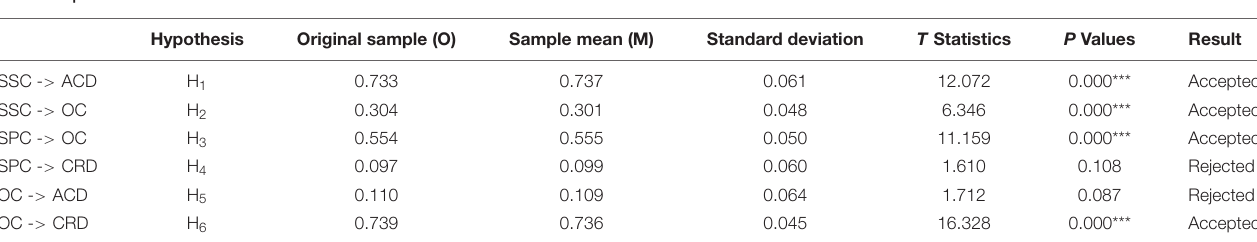
FIGURE 3 | Output of structural model bootstrapping.SSC, social skills coaching; SPC, sports coaching; ACD, academic development; CRD, career development; OC, organizational climate. TABLE 5 | The direct effects of the variables.